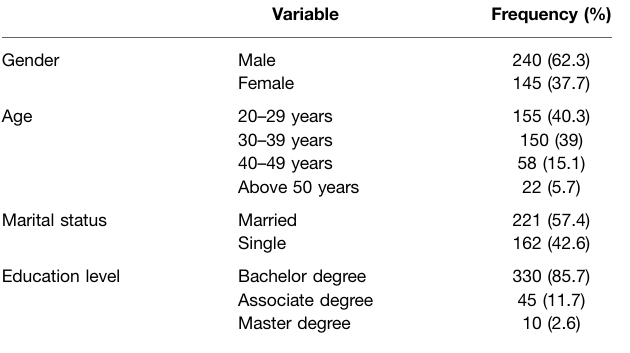
TABLE 1 | Demographic characteristics of the operating room personnel.